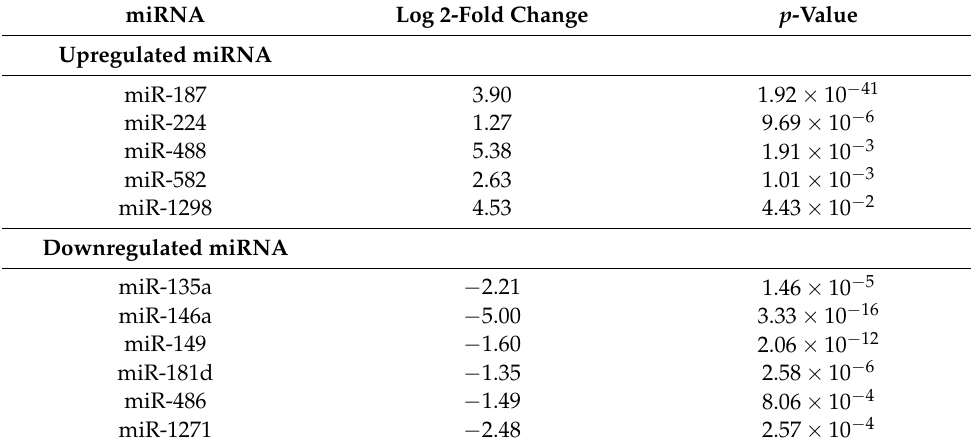
Table 1. Summary of significantly differentially expressed miRNAs in suspension cells compared to adherent cells. miRNA Log 2-Fold Change p -Value Upregulated miRNA miR-187